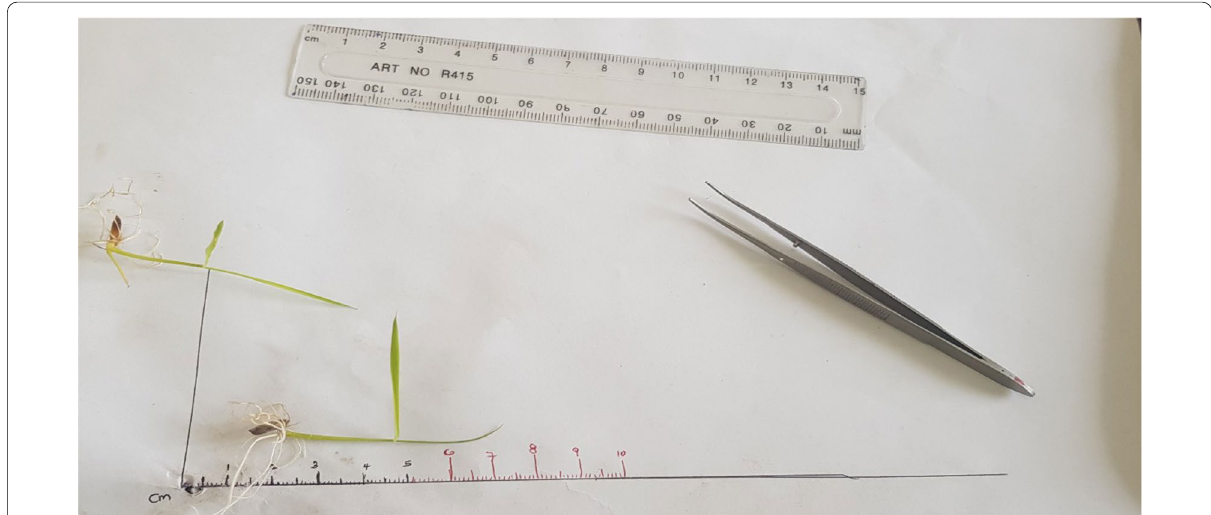
Fig. 14 Measurement of germinating seedling using a transparent ruler on a calibrated white paper.